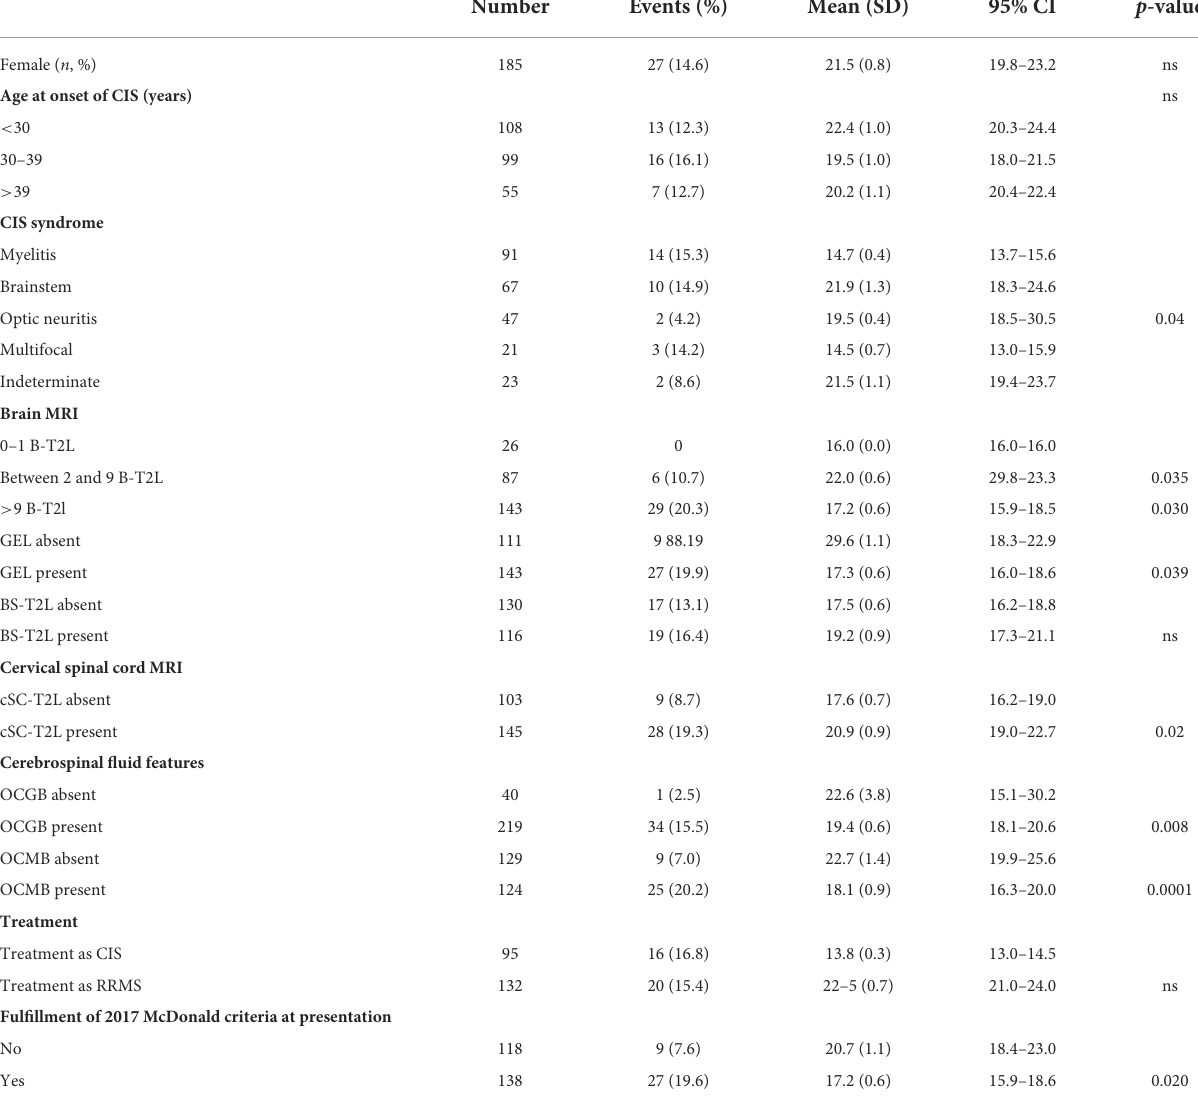
TABLE 2 Univariate Cox regression analysis of reaching a diagnosis of secondary progressive multiple sclerosis diagnosis according to the main clinical